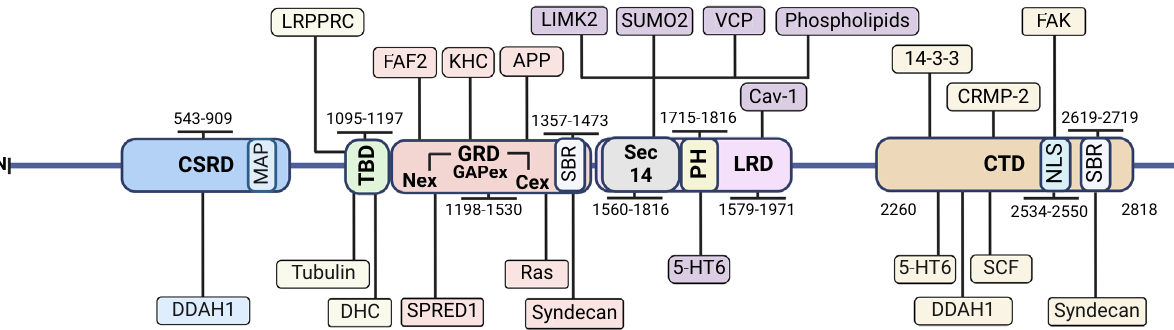
Fig. 1 Neuro fi bromin domains and interacting partners. CSRD (cysteine-serine rich domain, residues 543 – 909), TBD (tubulin-binding domain, residues 1095 – 1197), GRD (GAP-related domain, residues 1198 – 1530), Sec14-PH (residues 1560 – 1816), LRD (leucine-rich domain, residues 1579 – 1971), the CTD (C- terminal domain, residues 2260 – 2818) including the NLS (bipartite nuclear localization signal domain, residues 2534 – 2550) and SBR (syndecan-binding region, residues 1357 – 1473 and 2619 – 2719). Domains are in bold whereas interacting partners are shown in colored boxes according to their